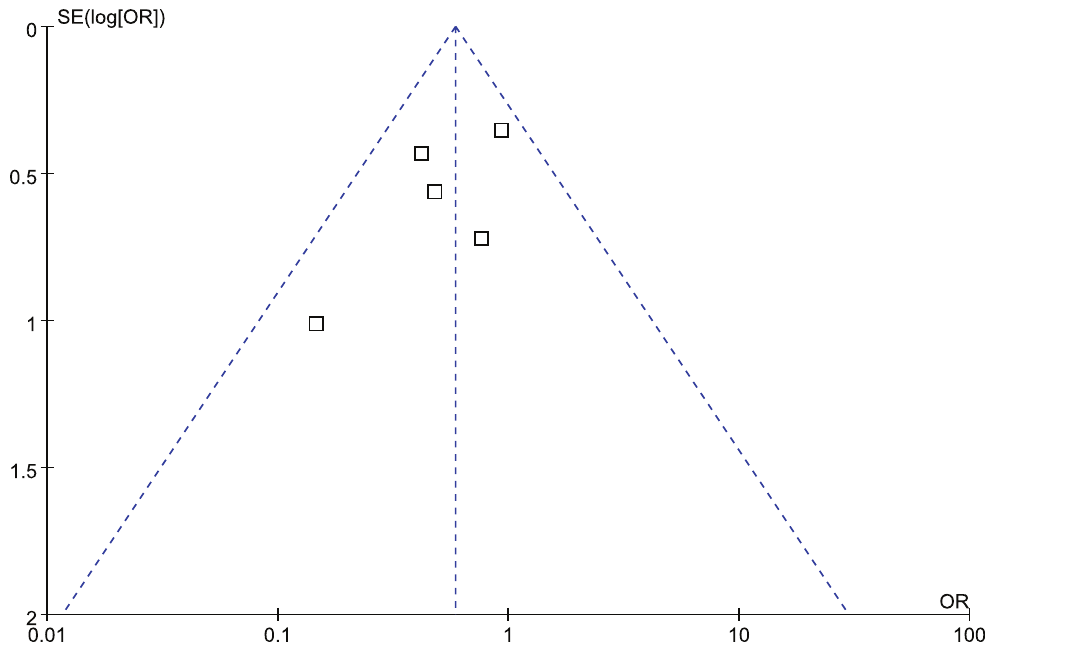
Figure 8. Funnel plot demonstrating the absence of publication bias among the studies that reported overall complications.